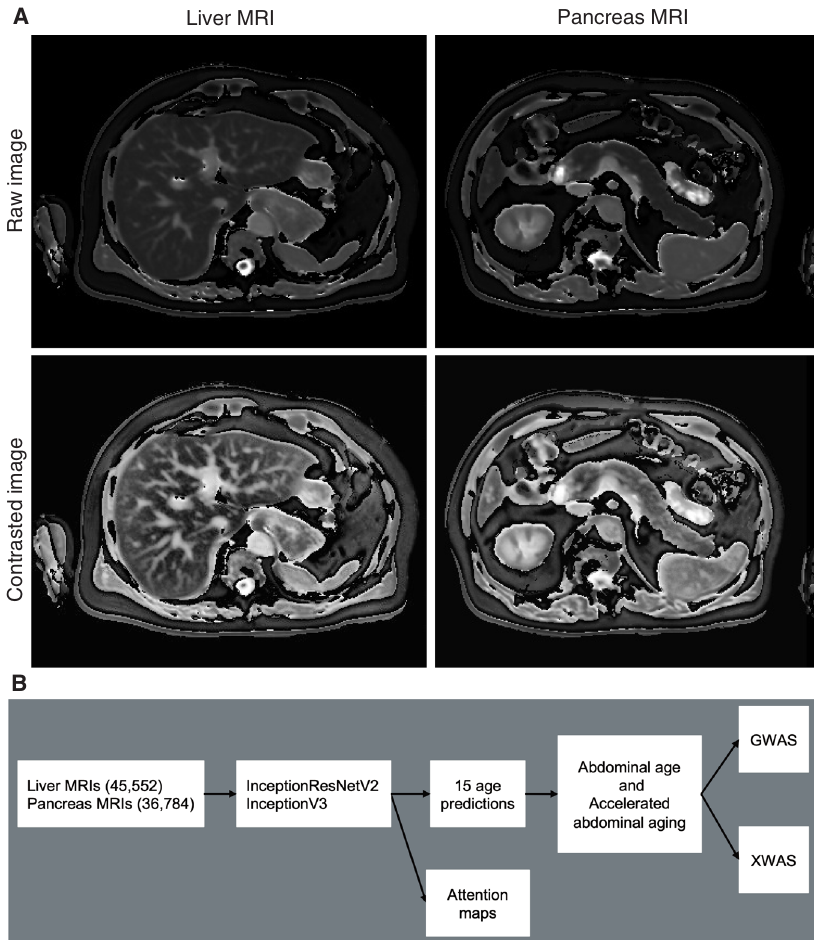
Fig. 1 Overview of the datasets and analytic pipeline. A Sample liver and pancreas MRI images, both raw and preprocessed with a contrasting fi lter. B Schematic of Analytic pipeline. B : Sample sizes are in parentheses.